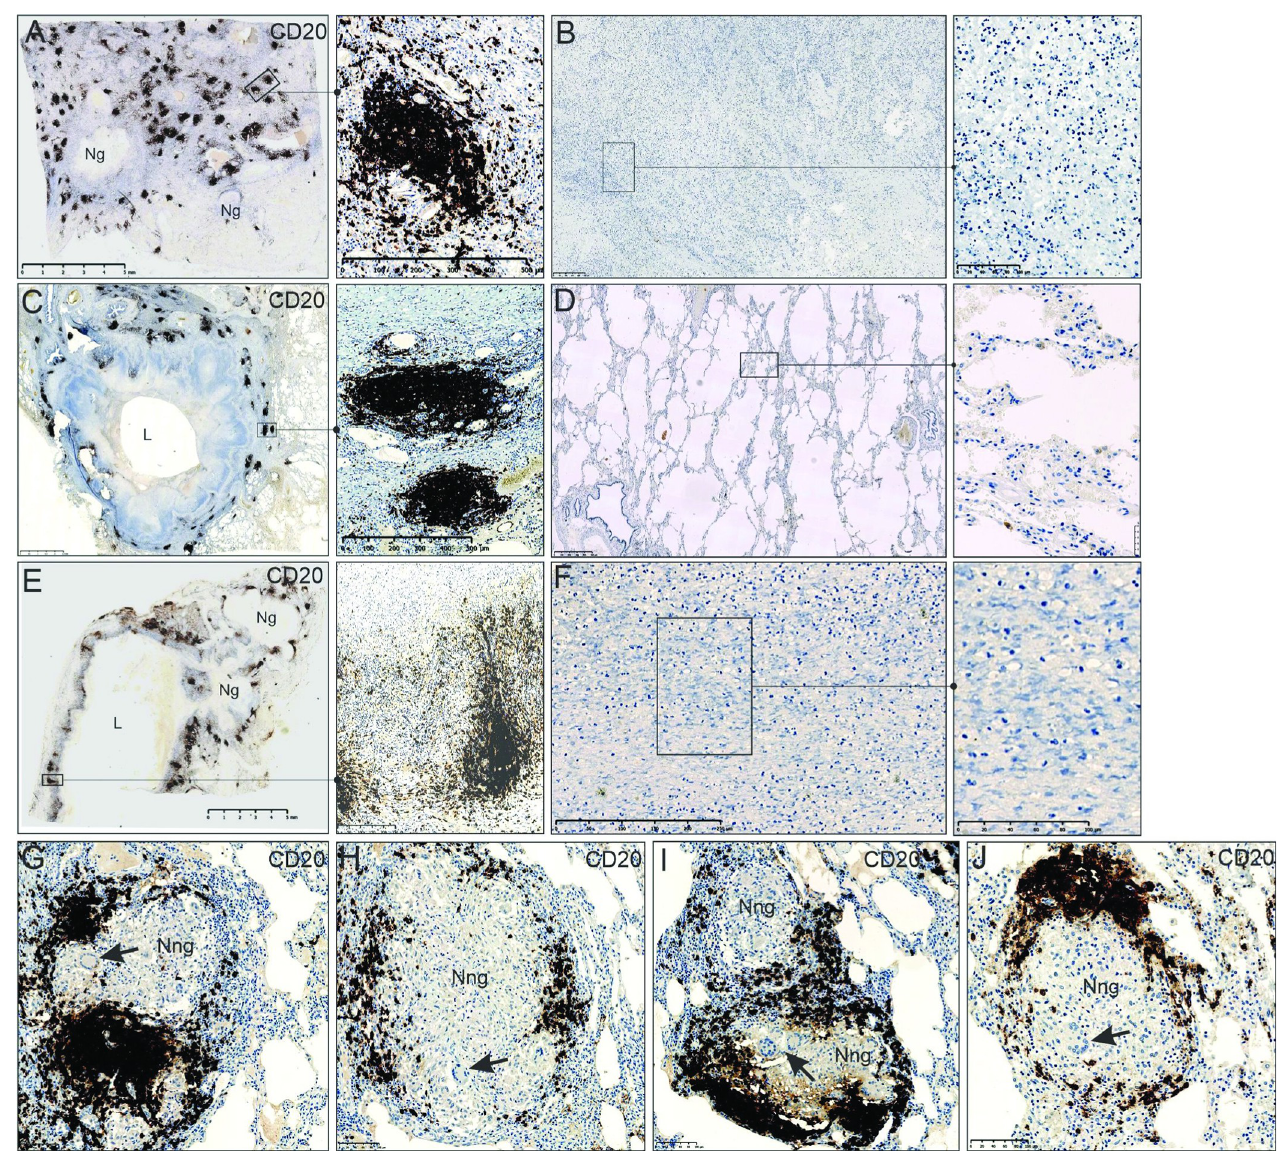
Fig 7. Conspicuous B cell aggregates are present at the periphery of cavitary and necrotic lesions in human tuberculous lungs. (A), (C), and (E) depict low power images demonstrating the histopathology of lung tissue from three patients infected with M . tuberculosis (see Table 1 for patient information). The medium and high-power images to the right of (A), (C), and (E) illustrate the corresponding B cell aggregates, as detected by anti-CD20 staining. The medium- and high-power images (B), (D), and (F) illustrate regions of tuberculous lung tissue from three patients with varied degree of consolidation (from non- consolidated to markedly consolidated areas) distal to cavitary or necrotic lesions, in which B cells aggregates are conspicuously absent. Photomicrographs of (G-J) show non-necrotic granulomas surrounded by CD20 + B cell aggregates, which may represent evolving lesions in transition to a necrotic and/or cavitary state as tissue-damage progresses. Tissue sections were prepared from formalin-fixed, paraffin-embedded lung specimens surgically removed from tuberculous patients. Ng: necrotic granuloma; Nng: non-necrotic granuloma; L: lumen of cavity. Arrows–Langhans giant